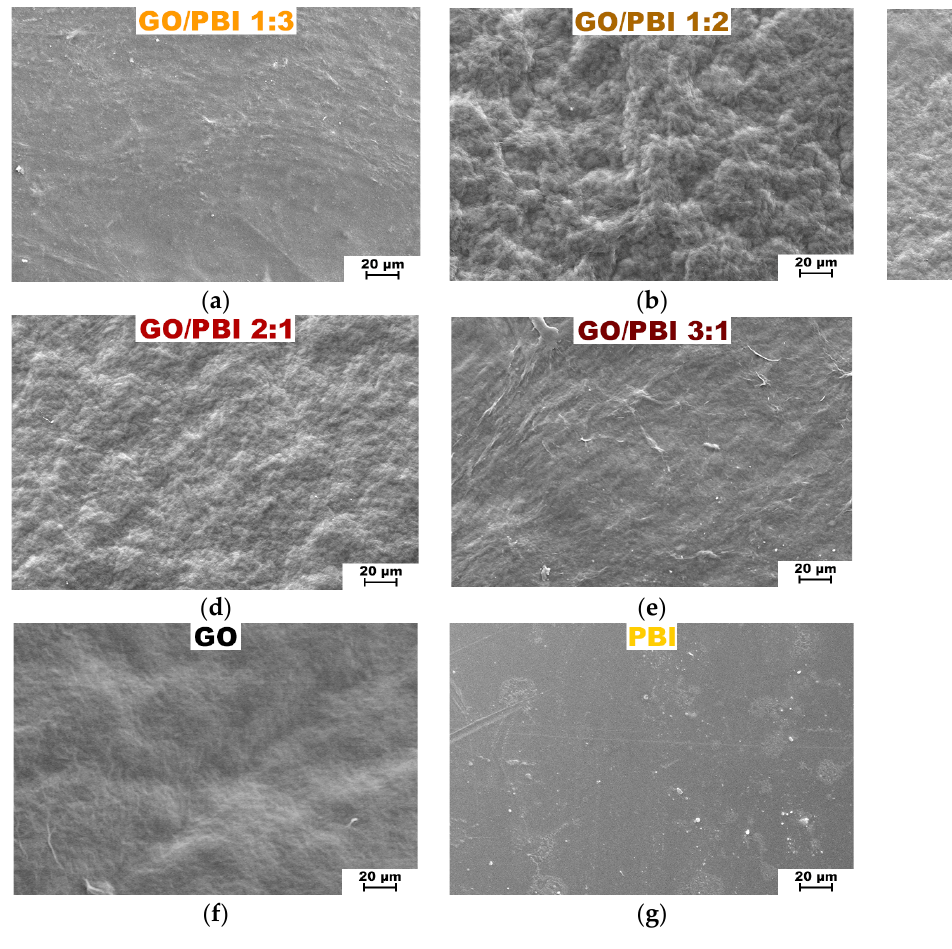
Figure 3. SEM images at 1000× magni fi cation of the composite membranes: ( a ) GO/PBI 1:3; ( b ) GO/PBI 1:2; ( c ) GO/PBI 1:1; ( d ) GO/PBI 2:1; ( e ) GO/PBI 3:1. SEM images at 1000× magni fi cation of ( f ) pure GO membrane and ( g ) pure PBI membrane are reported for comparison.